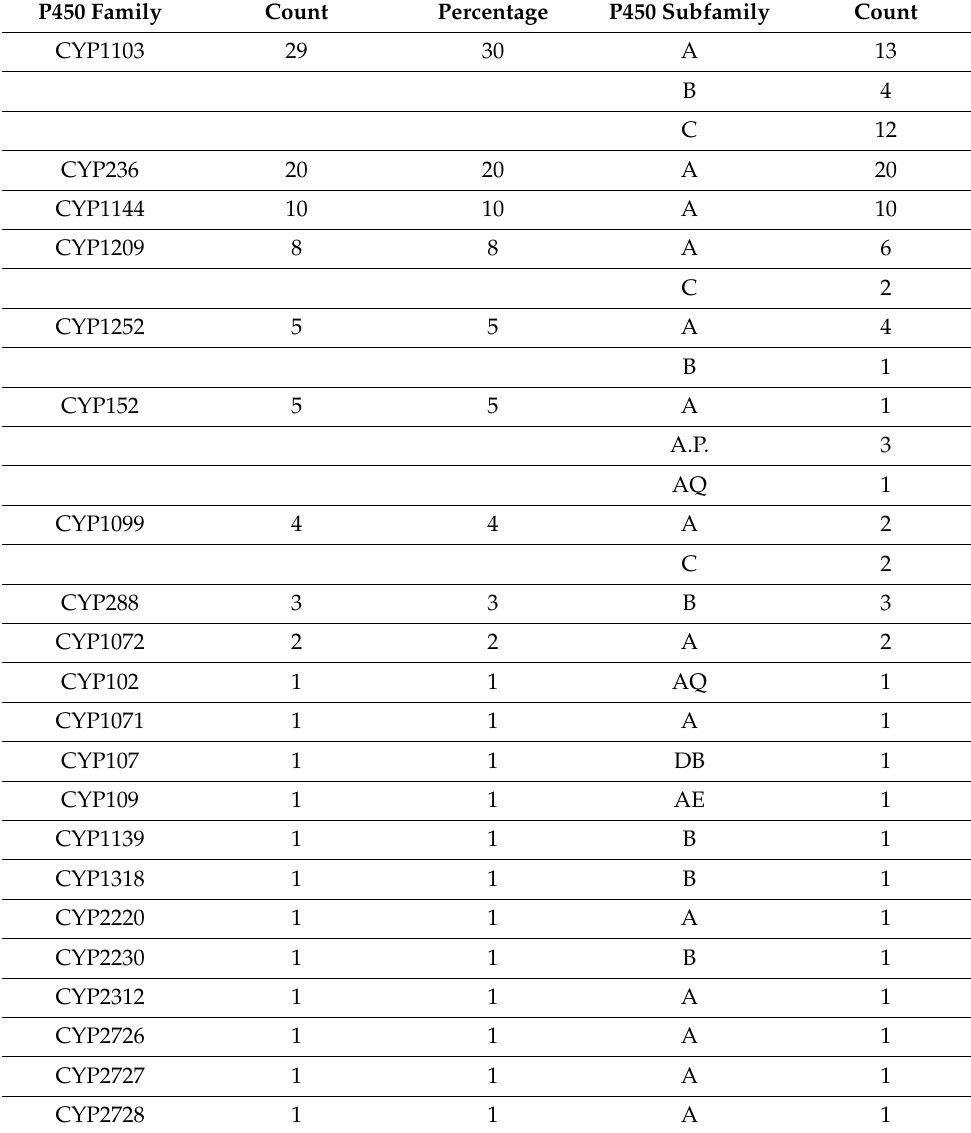
Table 3. Comparative analysis of P450 families and subfamilies in Bacteroidetes species. P450